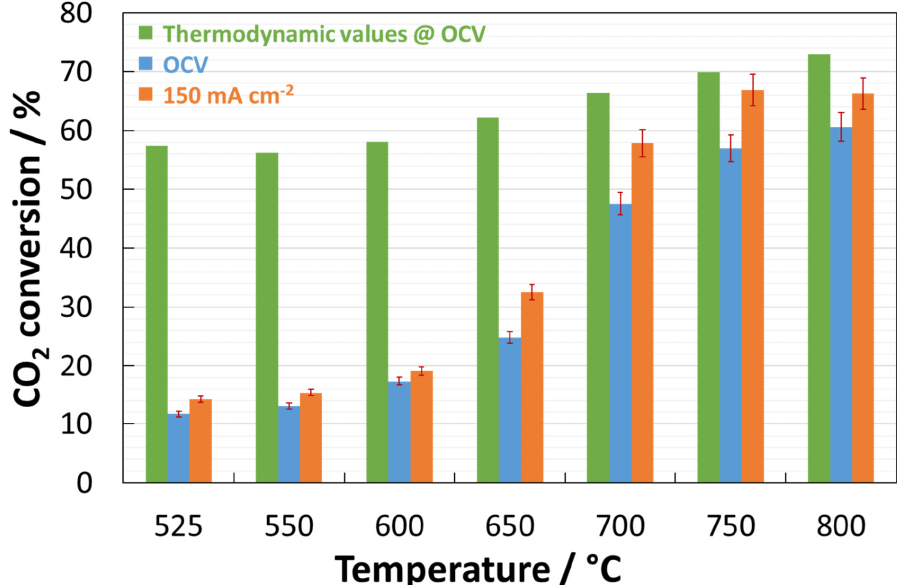
Figure 2. CO 2 conversion based on thermodynamic prediction and under practical conditions treated according to Equation (3).